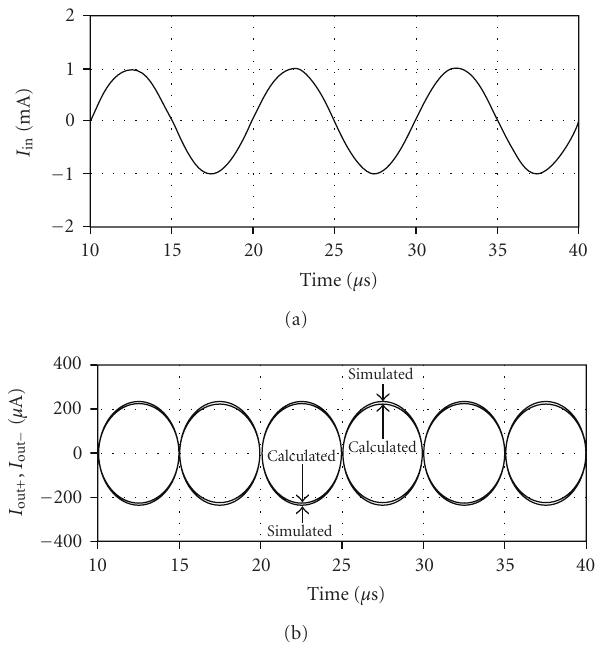
Figure 6: Operation of circuit for the 100 kHz sine wave input signal: (a) input waveform; (b) output waveforms.